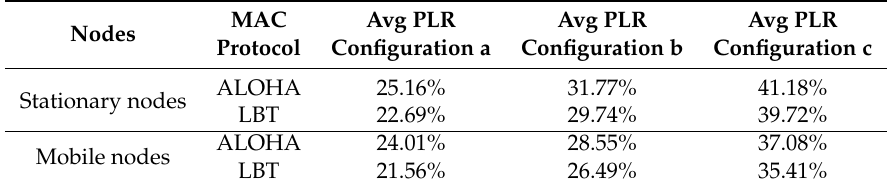
Table 6. Average PLR varying traffic